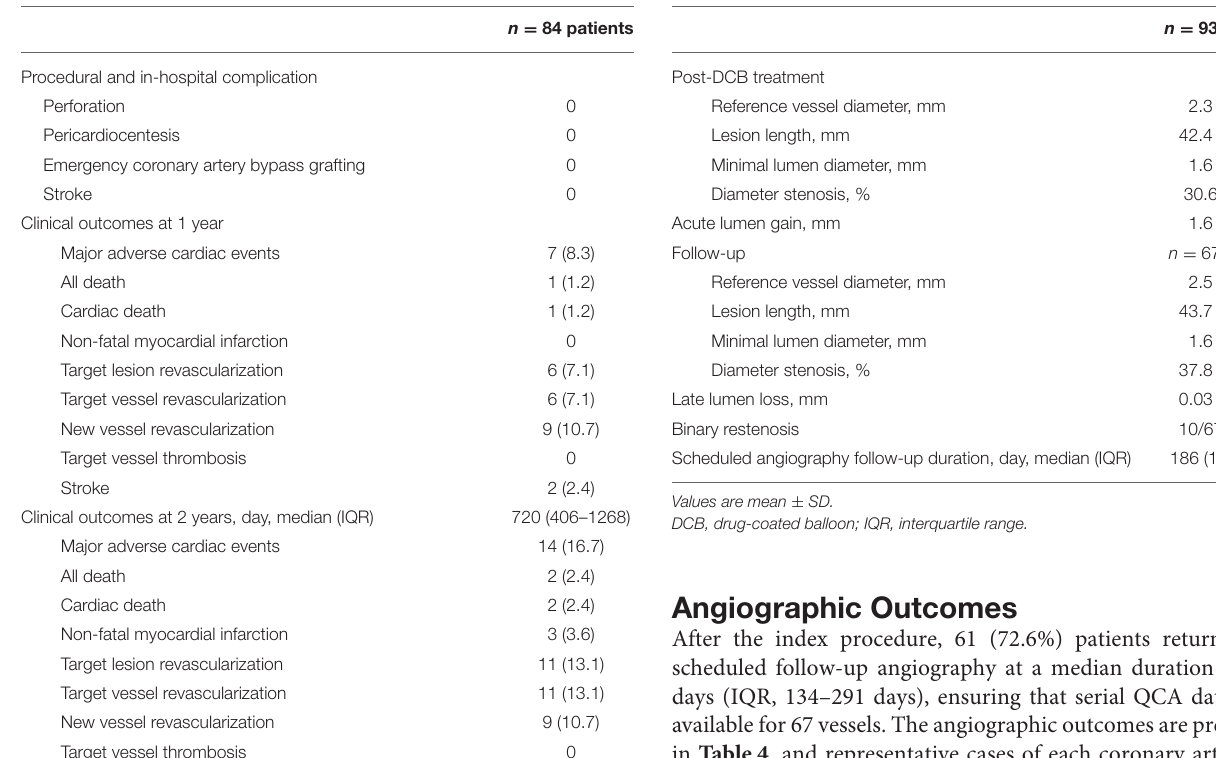
TABLE 3 | Procedural complications and clinical outcomes. TABLE 4 | Quantitative coronary angiography and late luminal